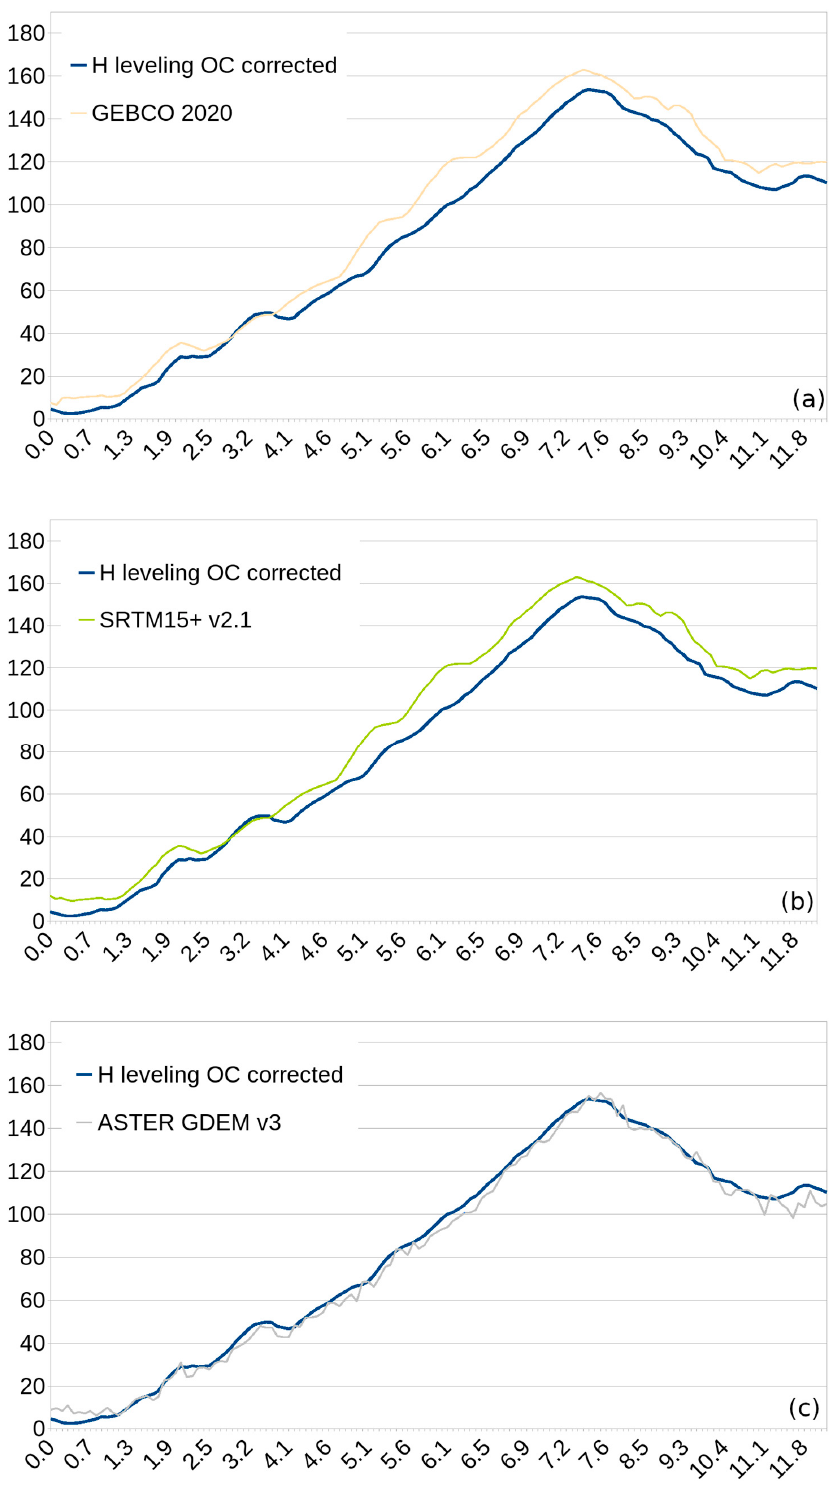
Figure 3. Height values along the traverse in Central Greece from ( a ) GEBCO2020 (light orange line) and leveling, ( b ) SRTM15+ (light green line) and leveling, and ( c ) ASTER GDEM v3 (gray line) and leveling. ( x ‐ axis: distance in km/ y ‐ axis: height in m).